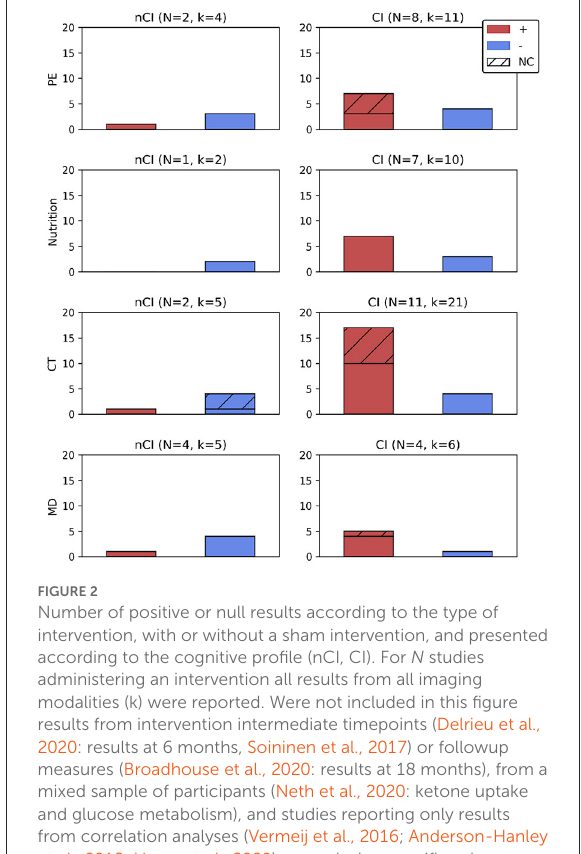
FIGURE2 Number of positive or null results according to the type of intervention, with or without a sham intervention, and presented according to the cognitive profile (nCI, CI). For N studies administering an intervention all results from all imaging modalities (k) were reported. Were not included in this figure results from intervention intermediate timepoints (Delrieu et al., 2020: results at 6 months, Soininen et al., 2017) or followup measures (Broadhouse et al., 2020: results at 18 months), from a mixed sample of participants (Neth et al., 2020: ketone uptake and glucose metabolism), and studies reporting only